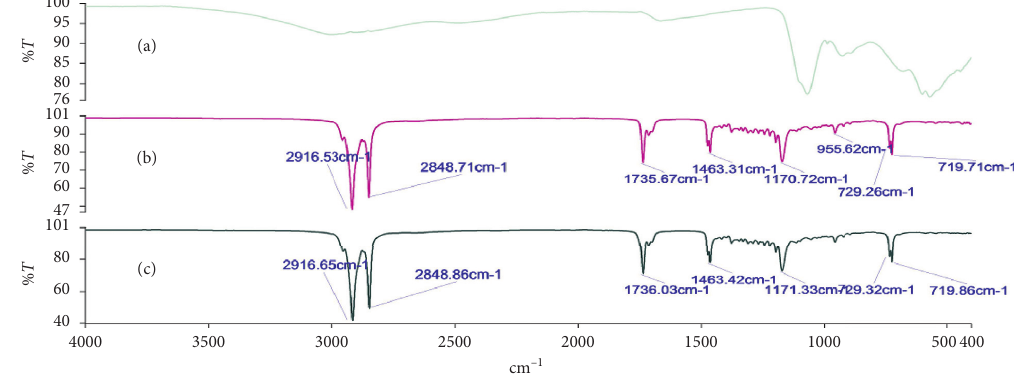
Figure 4: FT-IR spectra of (a) alum, (b) beeswax +alum (1:1), and (c)